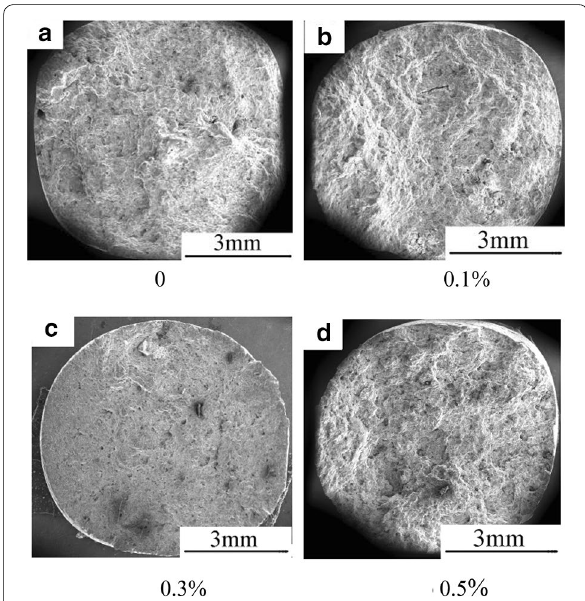
Figure 1 Macro‑fracture structures of as‑cast alloy with the addition of different Y